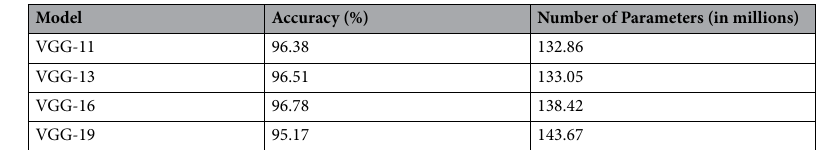
Table 2. Performance (measured in terms of accuracy) provided by the different VGG variants along with their number of parameters on the SARS-COV-2 dataset.